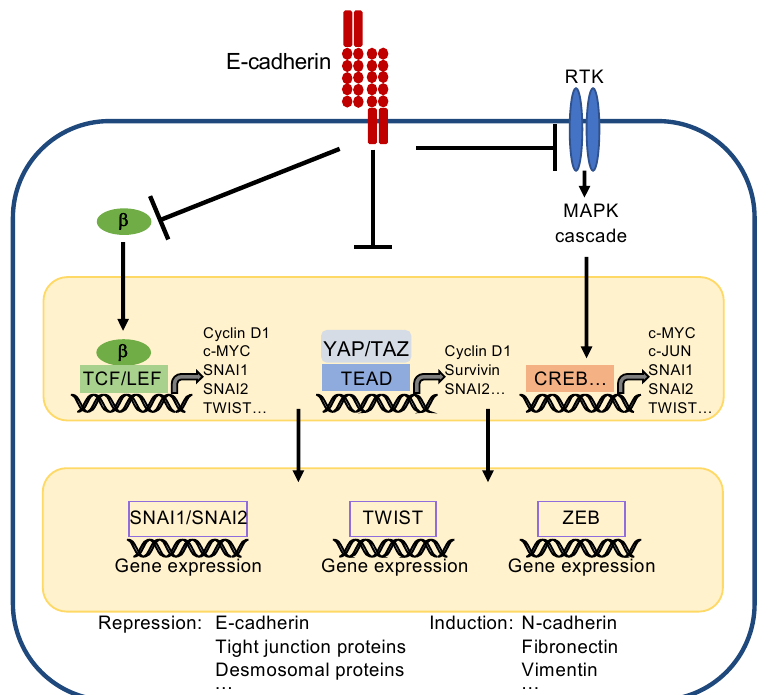
Figure 4. Simplified scheme to present principles of EMT. The core transcription factors inducing EMT are SNAI1/SNAI2, TWIST, and ZEB. They reduce expression of epithelial markers, such as E-cadherin, and induce expression of mesenchymal markers, such as N-cadherin. They are regulated by upstream acting transcription factors, which also support proliferation, survival, and EMT by their own gene expression. (Note: CREB is representative for all transcription factors activated by the MAPK cascade). E-cadherin inhibits EMT by recruiting β-catenin (β), sequestering YAP/TAZ, and by inhibiting activity of receptor tyrosine kinases (RTKs), which, e.g., activate the mitogen-activated protein kinase (MAPK) cascade.